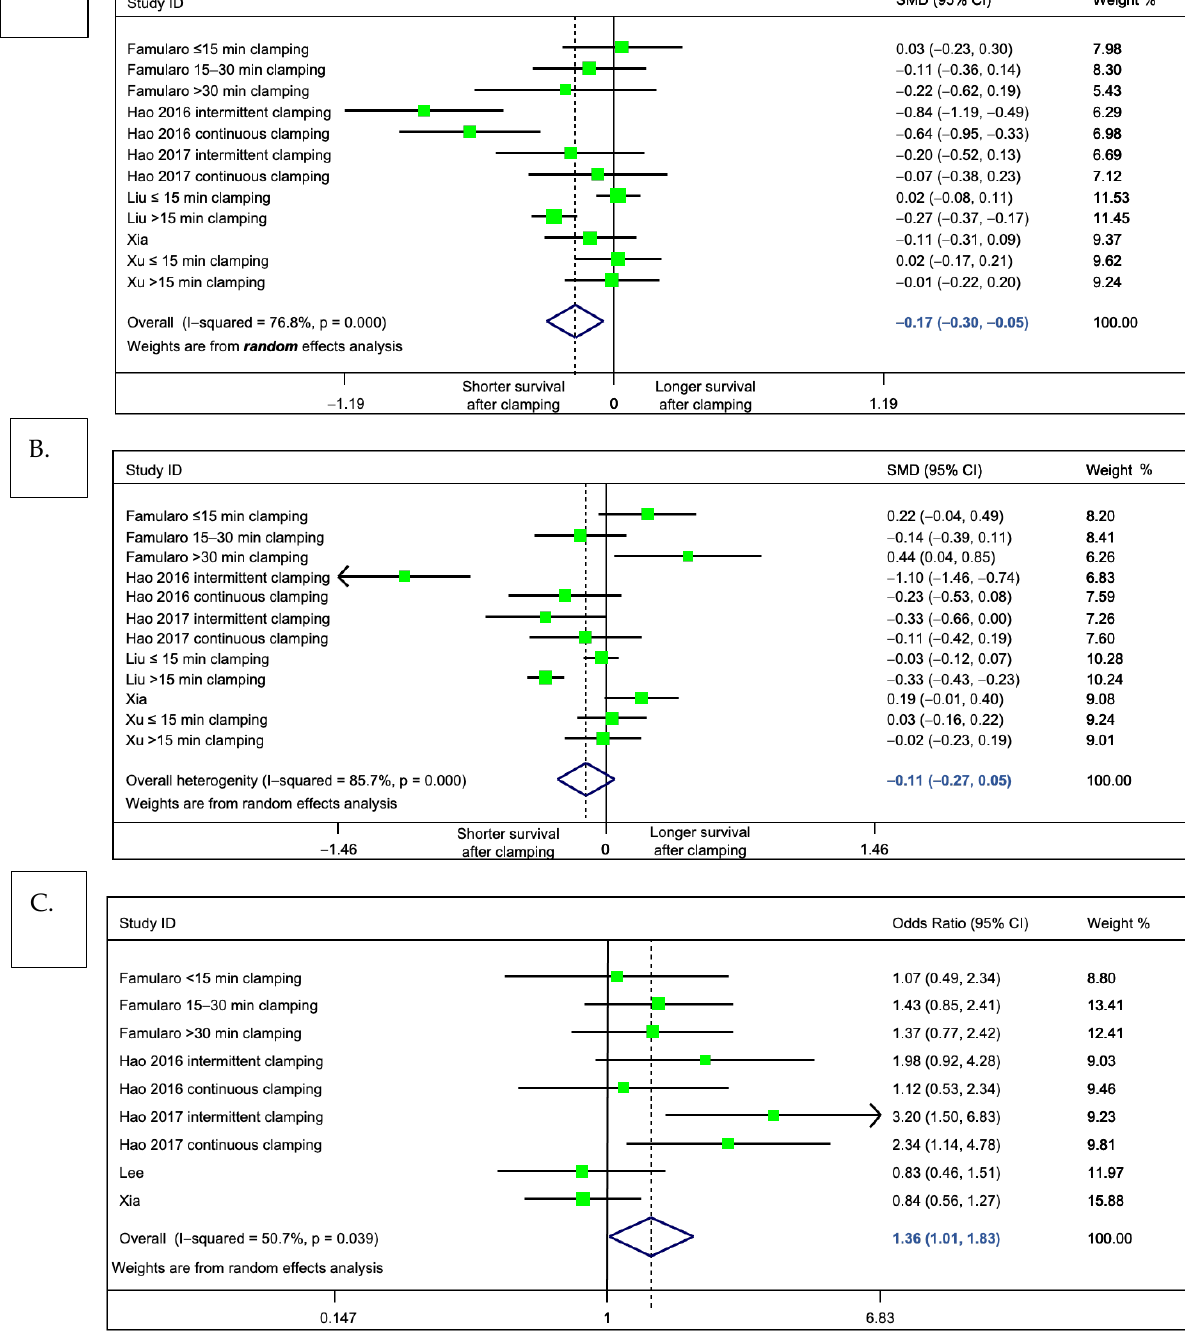
Figure 4. Meta-analysis comparing outcomes of patients undergoing liver pedicle clamping, versus no-clamping. Forest plots depict results obtained by random-effects meta-analysis. The vertical solid line depicts the null hypothesis, and the dashed line indicates the pooled effect estimate. ( A ) Primary outcome, overall survival (standardized mean difference). ( B ) Secondary outcome, disease-free survival (standardized mean difference). ( C ) Secondary outcome, overall probability of tumor recurrence (odds ratio). Note that in the main meta-analyses, the study by Huang et al. was excluded, because it included a subgroup of patients with unclear pedicle clamping technique (“other clamping”). In a sensitivity analysis including this study, the pooled effect estimate did not differ from the main